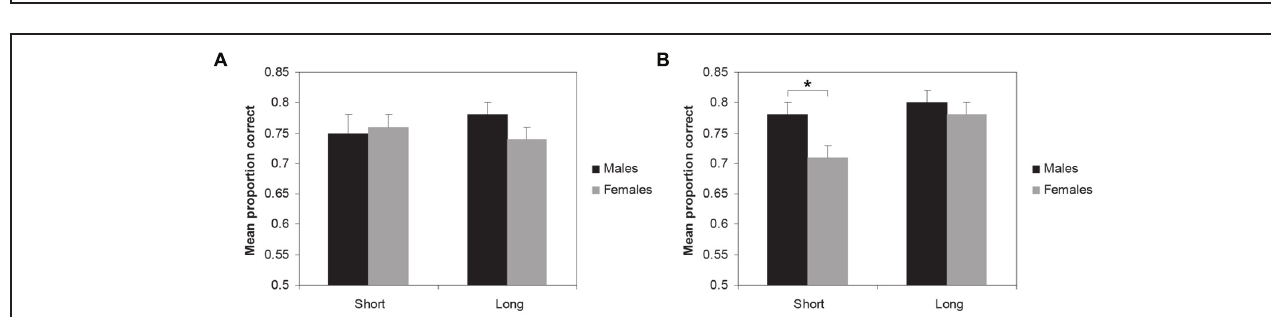
FIGURE 4 | Mean proportion of correct trials ( + SEM) in the distance comparison task for males and females who either had lived for a short or a long time in the city of Utrecht. (A) performance on distance pairs starting with the same place (B) performance on distance pairs starting with a different starting place. * p < 0.05.